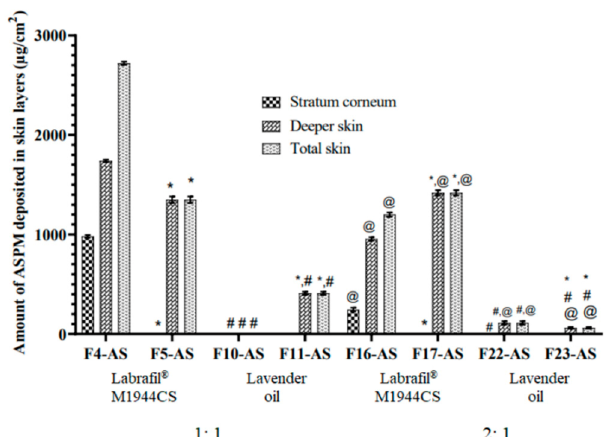
Figure 5. Deposition of asenapine from ASP-loaded LNCs in different skin layers. All values are presented as the mean ± SD ( n = 6). * Significant difference in comparison to the formulation con- taining Kolliphor ® HS with the same oil type and ratio. # Significant difference in comparison to the formulation containing Labrafil ® M1944CS with the same surfactant type and oil ratio. @ Significant difference in comparison to the formulation with an oil:surfactant ratio of 1:1 with the same oil and surfactant